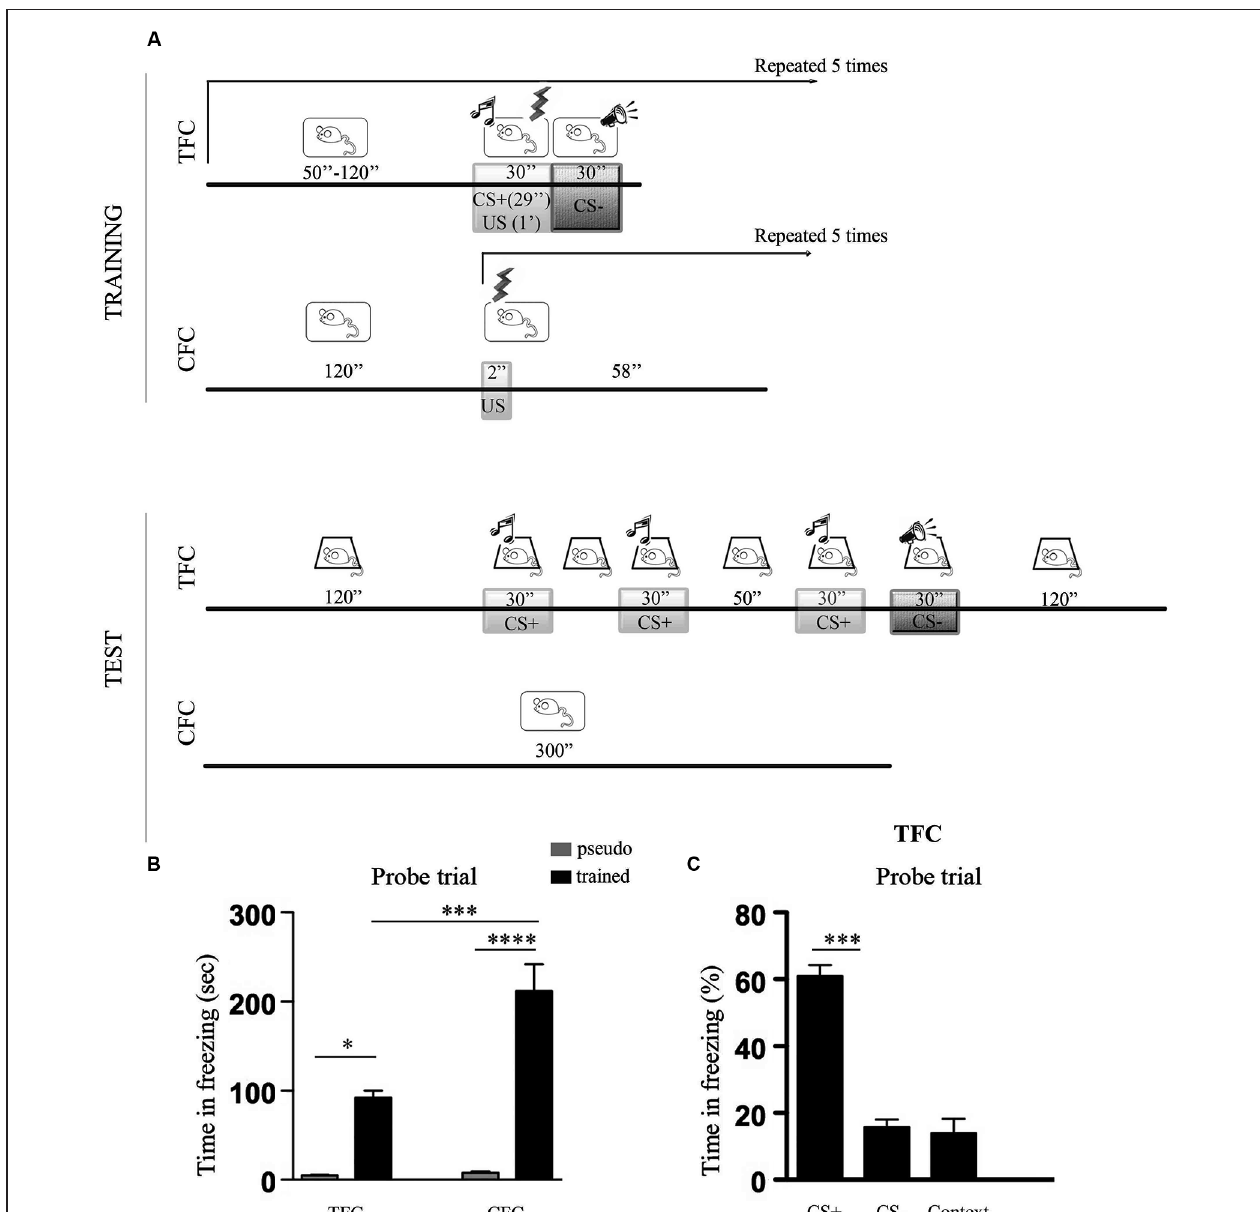
FIGURE 1 | Percentage of freezing during TFC and CFC. (A) Cartoons depicting TFC and CFC training and testing protocols. TFC training : after a 120 s habituation period to context A, mice were exposed to five tone-footshock pairings followed by a white noise. The tone (CS+, 7, 5 kHz, 30 s) terminated at the onset of the footshock (US, 0, 7 mA, 1 s) while the white noise (CS − ) started when the footshock terminated. CS+/US/CS − presentations were administered at intervals (I) ranging from 50 s to 120 s. TFC testing : mice were placed 24 h later in context B and, after a 120 s habituation period, exposed to 3 CS+ (30 s) separated by intervals of 30 s and 50 s. After a 10 s interval, they were exposed to 1 CS − and then left 90 s in the conditioning chamber (context exposure). CFC training : mice were placed in context A and, after a 120 s habituation period, they were exposed to five footshocks were delivered through the grid floor at 1 min